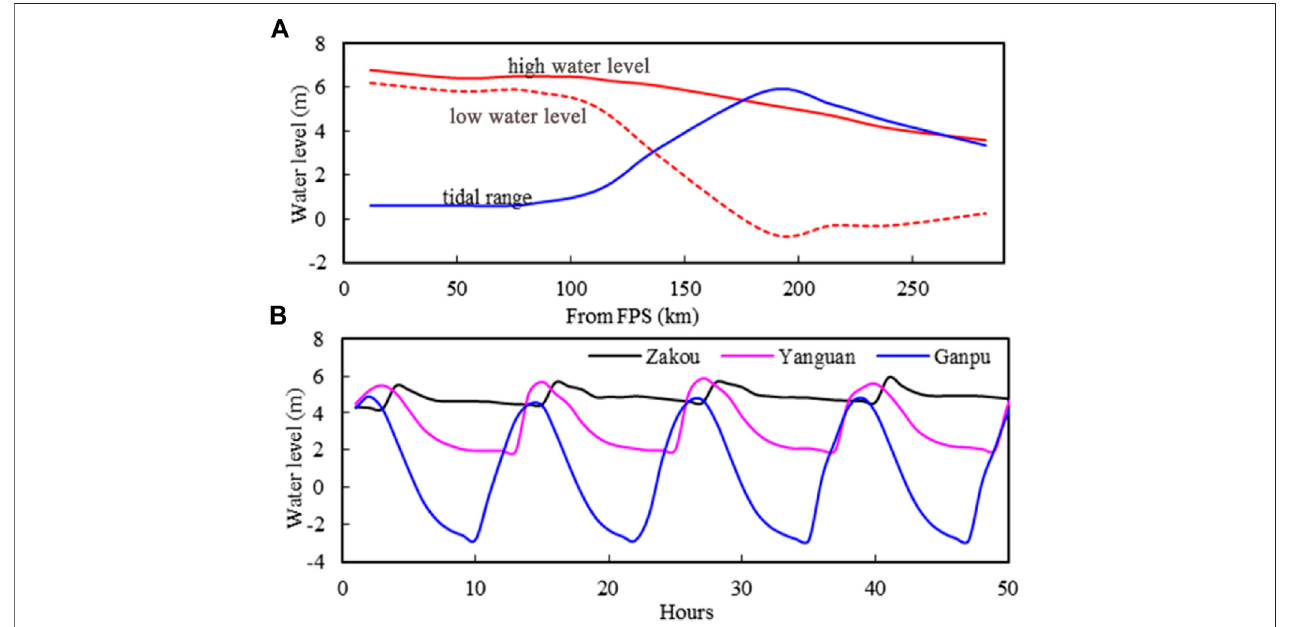
FIGURE 2 | Multi-year averaged high and low water levels and tidal range along the estuary (A) , and an example of the time series of water levels at the Zakou, Yanguan and Ganpu stations during spring tide in September 2015 (B) .